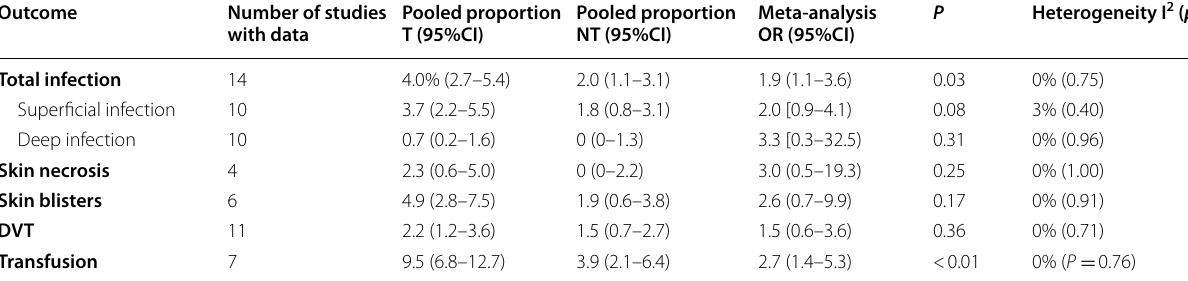
Table 4 Meta-analysis comparing the outcomes between the two groups Outcome Number of studies